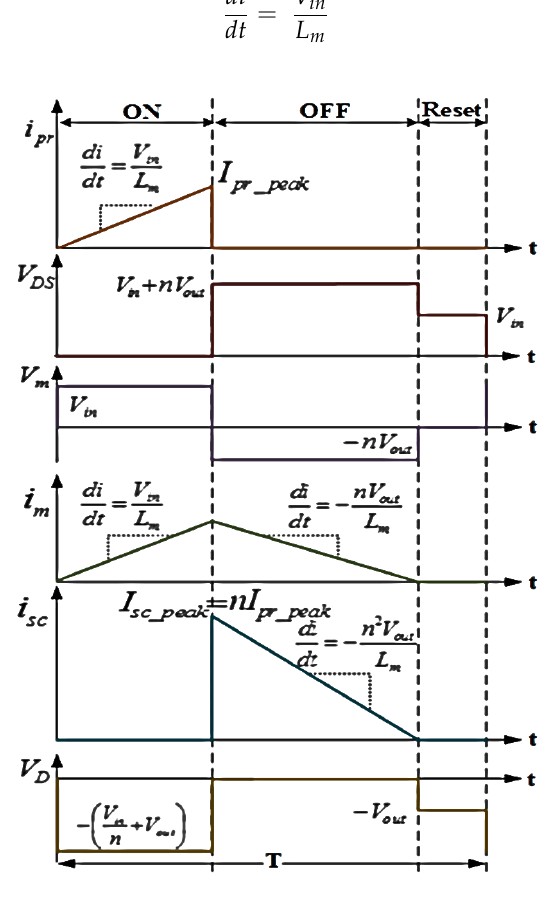
Figure 6. Key waveforms of DCM control of Li-ion battery discharging.